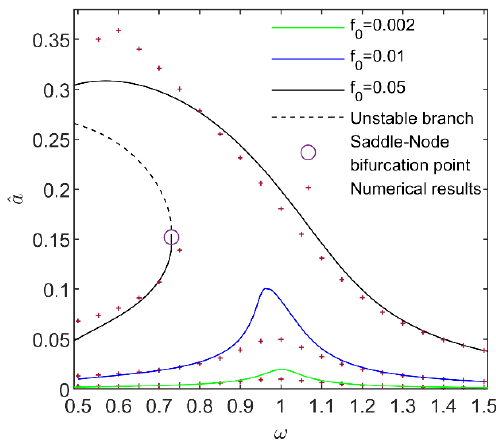
Figure 3. Variation of the amplitude of periodic solutions near (0, 0) with the change of ω . When two intra-well attractors around the well center O (0, 0) or ( ,0) termine the branch to which the response attracts. For the purpose of energy harvesting, the initial conditions should be chosen to follow the high-amplitude one in order to output high voltage consequently. That is why we present the sequences of the attractors and their basins of attraction for the variation of the dimensionless external excitation. Basin of attraction means the union of initial conditions leading to the same attractor [20,21]. If the boundary of the basin of attraction of one attractor is fractal and intermingled with